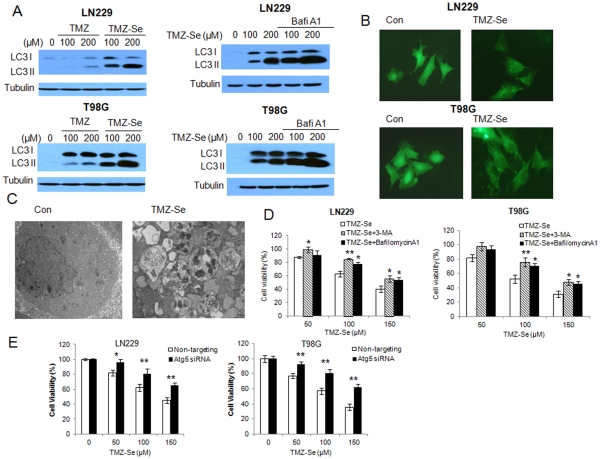
TMZ-Se triggers a greater autophagic response than TMZ, and inhibition of autophagy decreases the efficacy of TMZ-Se against glioma cells.(A) Left panels: LN229 and T98G cells were treated with TMZ or TMZ-Se for 48 h, and the level of LC3 was measured by Western blot analysis. Tubulin was used as a loading control. Right panels: LN229 and T98G cells were treated with TMZ-Se for 48 h in the presence or absence of bafilomycinA1, and the level of LC3 was measured by Western blot analysis. Tubulin was used as a loading control. (B) LN229 and T98G cells were transfected with a GFP-LC3 plasmid, followed by treatment with TMZ-Se for 48h. At the end of treatment, the cells were observed under fluorescence microscope. (C) T98G cells treated with TMZ-Se or vehicle were harvested by trypsinization, fixed and embedded in spur resin. Ninety nm thin sections were cut and examined at 80 Kv with a JEOL 1200EX transmission electron microscope. (D) LN229 and T98G cells were treated with TMZ-Se for 48h in the absence or presence of 3-MA or bafilomycinA1, and cell viability was measured by MTT assay. (E) LN229 and T98G cells were transfected with an Atg5-targeted siRNA, and then treated with TMZ-Se for 48h. Cell viability was measured by MTT assay. *p < 0.05; **p < 0.01.